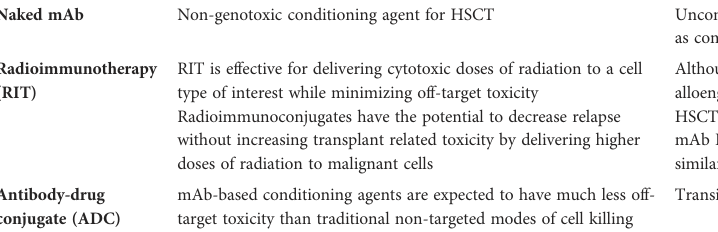
TABLE 2 The pros and cons of antibody-based approaches in HSCT. HSC targeting agent Naked mAb Non-genotoxic conditioning agent for